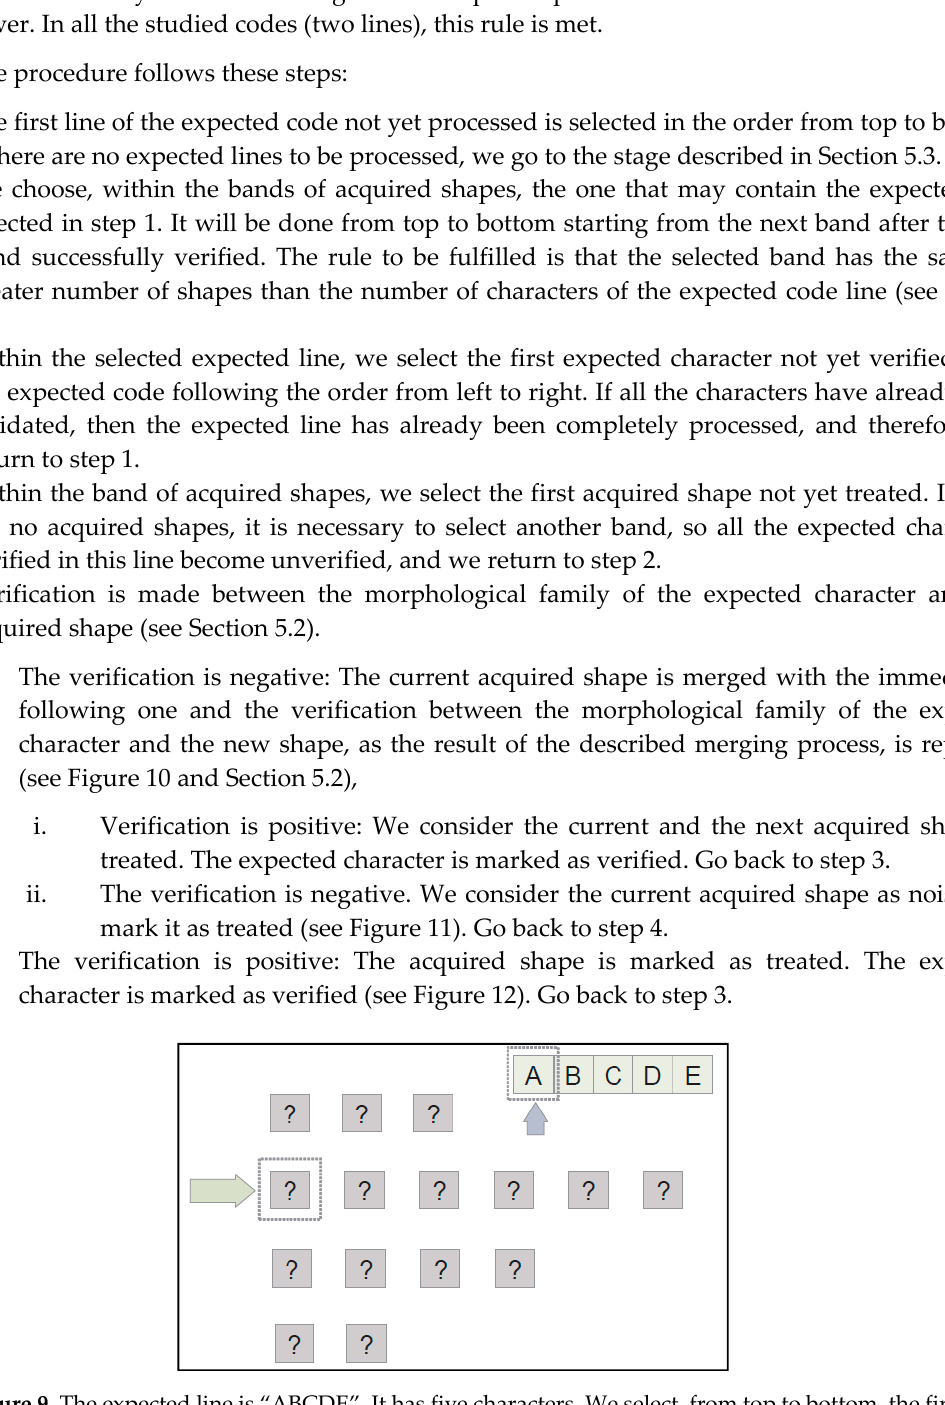
Figure 9. The expected line is “ABCDE”. It has five characters. We select, from top to bottom, the first band with enough acquired shapes to contain five